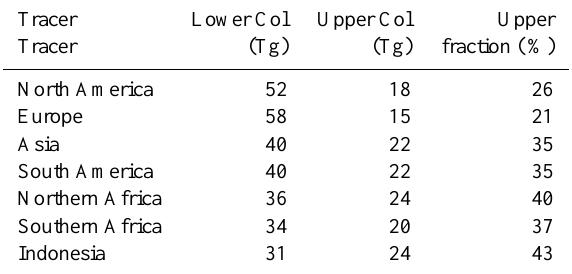
Table 2. Monthly mean mass of continental CO tracers (Tg) in the boundary layer (lower column) and the free troposphere (upper col- umn). The upper fraction is calculated by Mass_upper / Mass_total. The region definition is shown in Fig.